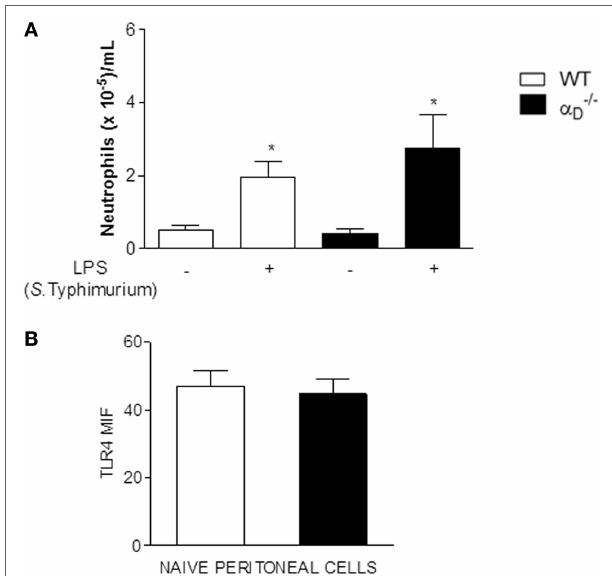
FIGURE 3 | Recognition of Salmonella Typhimurium lipopolysaccharide (LPS), LPS signaling, and toll-like receptor 4 (TLR4) expression are not altered in α –/– D mice. (A) α –/– D and wild-type (WT) mice were challenged with S. Typhimurium LPS (500ng) by intraperitoneal injection or injected with sterile, apyrogenic saline as a control. Peritoneal fluid was collected 24h later, and the numbers of leukocytes determined. Asterisks indicate significant differences between LPS- and saline-injected animals. (B) Peritoneal cells were collected from α –/– D and WT animals in the absence of bacterial infection or LPS challenge and analyzed for TLR4 expression by flow cytometry [mean fluorescence intensity (MIF)]. Each bar indicates the determinations in samples from (cid:21) 4 animals. The data in this figure are representative of three separate experiments.